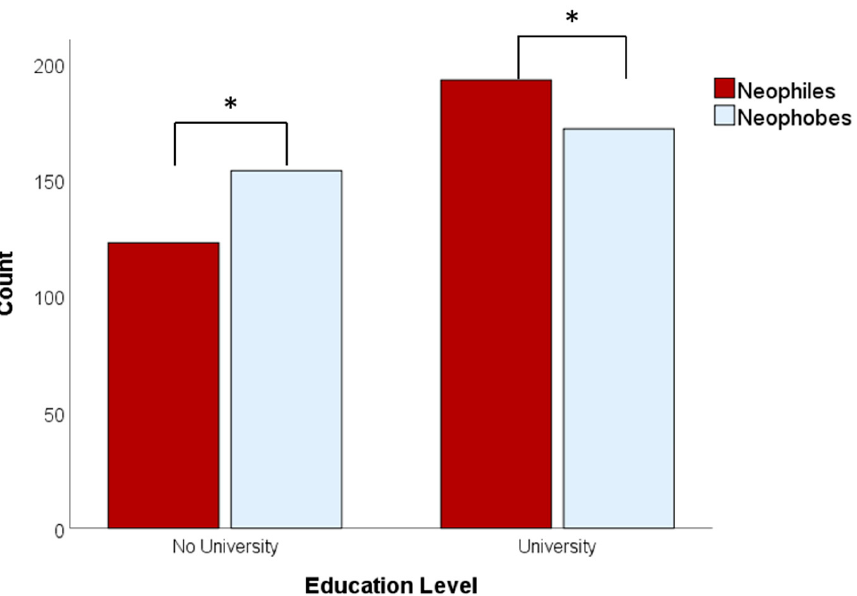
Figure 2. Results of chi-square analysis showing the number of neophiles (red) and neophobes (blue) as a function of whether or not participants were university educated. Asterisk (*) denotes a significant difference between groups.